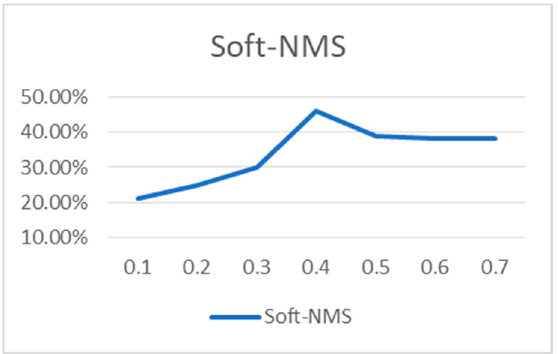
Figure 8. The figure shows the accuracy of person detection under different σ threshold values; the highest accuracy was achieved at 0.4. Table 2. The accuracy results of YOLOv3 improved using Soft-NMS and the retrieval algorithm. The test dataset was PASCAL VOC.